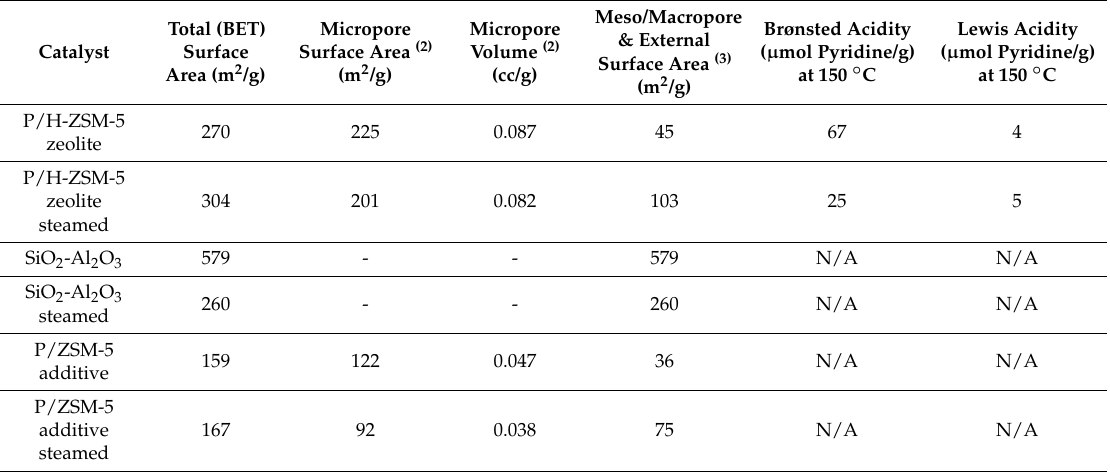
Table 2. Porosity characteristics of the fresh and steamed (1) , ZSM-5 zeolites, ZSM-5 additives, and amorphous